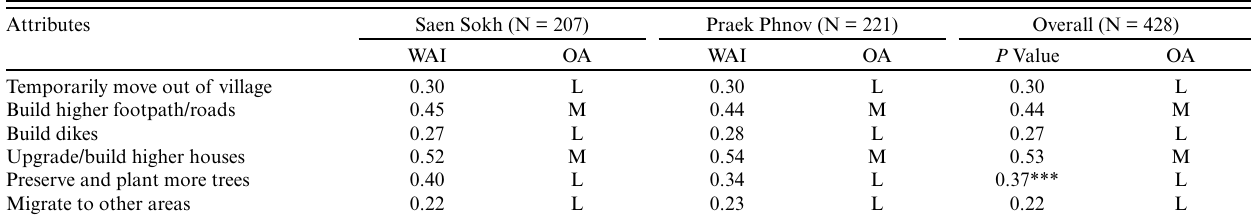
Table 4 . Perceptions on the level of effectiveness of strategies to cope with climate-related risks in urban communities. Attributes Saen Sokh (N = 207) Temporarily move out of village